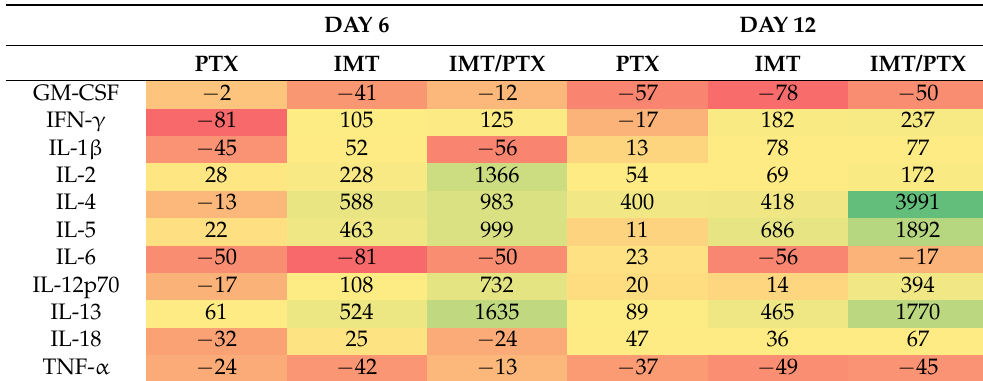
Figure 5. Histochemical imaging and quantitative analyses performed on E0771 tumors validates findings from analysis of granzyme B-specific positron emission tomography imaging data. Hematoxylin and eosin (H&E) staining and granzyme B expression in ( A ) day six tumors and ( B ) day 12 tumors are shown (20× magnification; scale: 125 µm). White arrows indicate necrotic regions. ( C ) Quantification performed on images (shows percentage of necrotic tissue from day six and 12 tumors. Mean ± SD (* indicates p < 0.05; unpaired t -test). Histogram analysis of pixel intensity in images of granzyme B staining on ( D ) day 6 and ( E ) day 12 tumors. Day six histograms: Control (blue) is different from paclitaxel (PTX), immunotherapy (IMT), and IMT/PTX distributions ( p < 0.0001). IMT (green) is different from IMT/PTX distribution (purple) ( p < 0.0001). Day 12 histograms: Control (blue) is different from PTX distribution (red; p < 0.006) and IMT (green) and IMT/PTX distributions (purple; p < 0.0001). Kolmogorov-Smirnov tests. Table 1. Paclitaxel (PTX), immunotherapy (IMT), or combination IMT/PTX resulted in differences in E0771 cytokine expression on days six and 12 before significant changes in tumor volume. Cytokine expression from mice given PTX, IMT, and IMT/PTX ( n = 3/group) shown as % differences of baseline. Lowest values displayed in red; highest values displayed in green. Abbreviations: Granulocyte- macrophage colony-stimulating factor (GM-CSF), interferon gamma (IFN- γ ), interleukin (IL), tumor necrosis factor alpha (TNF- α